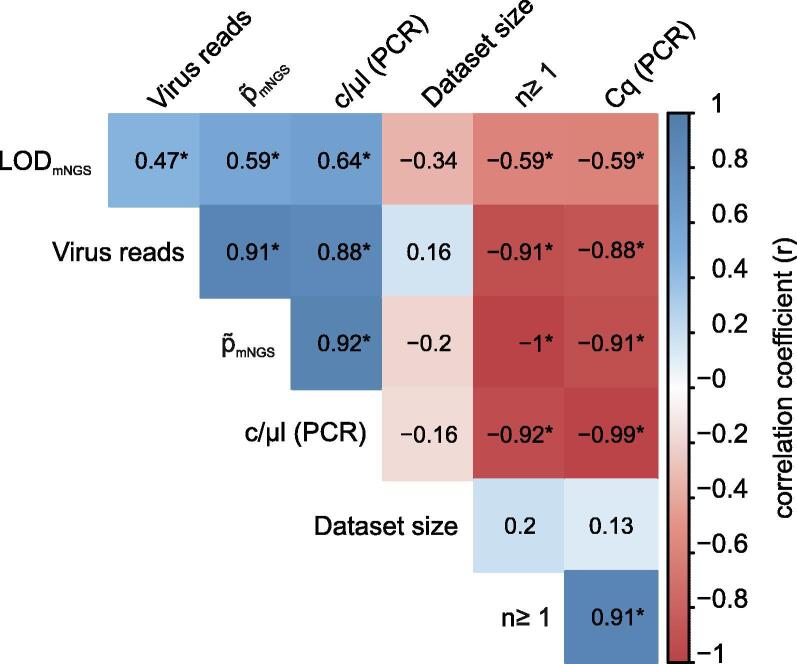
Correlation matrix of RT-qPCR impact factors for mNGS sensitivity. Values derived from samples and formula were compared. The correlation coefficient is displayed from + 1 to −1 (positive and negative correlation). An asterisk indicates p < 0.01.